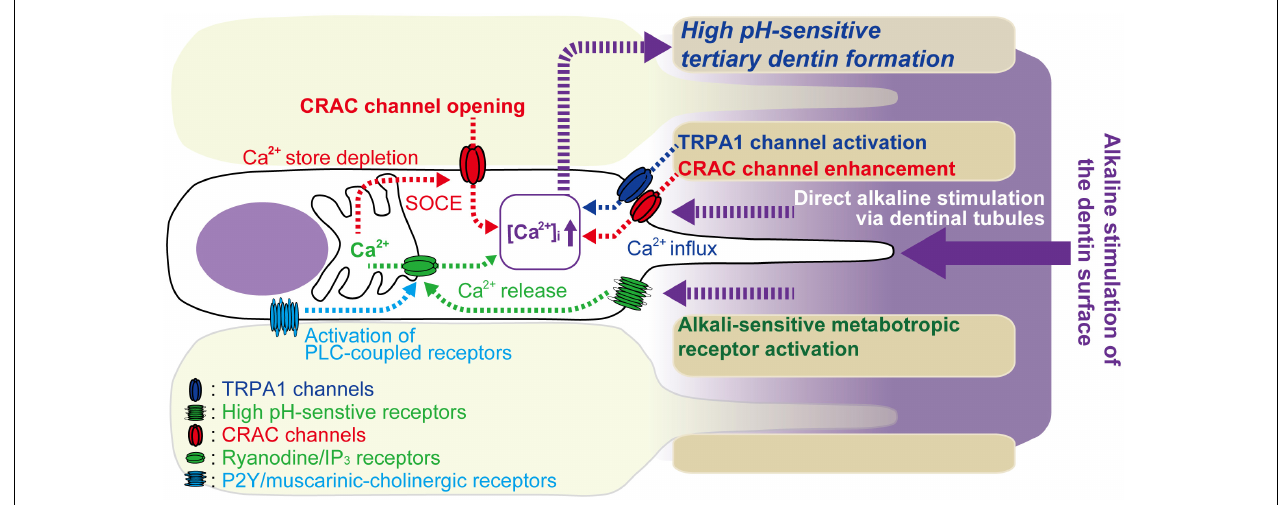
FIGURE 7 | Schematic of Ca 2 + signaling pathway activated by alkaline stimuli to dentin surface and PLC-coupled receptor activation in odontoblasts. Odontoblasts express PLC-coupled P2Y and muscarinic-cholinergic receptors. P2Y receptors are activated by endogenous ATP/ADP released from odontoblasts in the dental pulp in response to cellular deformation or cellular damage following dentin stimuli. Muscarinic-cholinergic receptors are activated by agonist released from intradental parasympathetic neurons. Activation of these receptors induces depletion of Ca 2 + stores by intracellular Ca 2 + release from intracellular Ca 2 + stores via ryanodine and/or IP 3 receptors, resulting in increased [Ca 2 + ] i . Ca 2 + store depletion then activates store-operated Ca 2 + entry (SOCE) via CRAC channels in odontoblasts. Direct alkaline stimuli via dentinal tubules to odontoblasts modulate CRAC channel activation and enhance Ca 2 + influx via CRAC channels. The alkaline stimuli also activate TRPA1 channels in odontoblasts and evoke Ca 2 + influx via TRPA1 channels. Additionally, alkaline stimuli activate alkali sensitive-metabotropic receptors, inducing Ca 2 + release from intracellular Ca 2 + stores via ryanodine and/or IP 3 receptors. This Ca 2 + release may, in turn, induce store depletion and SOCE via CRAC channels in odontoblasts. These high-pH-sensitive Ca 2 + signaling pathways may play important roles in tertiary dentin formation by odontoblasts, following application of alkali stimuli, such as high-pH dental materials, on the dentin